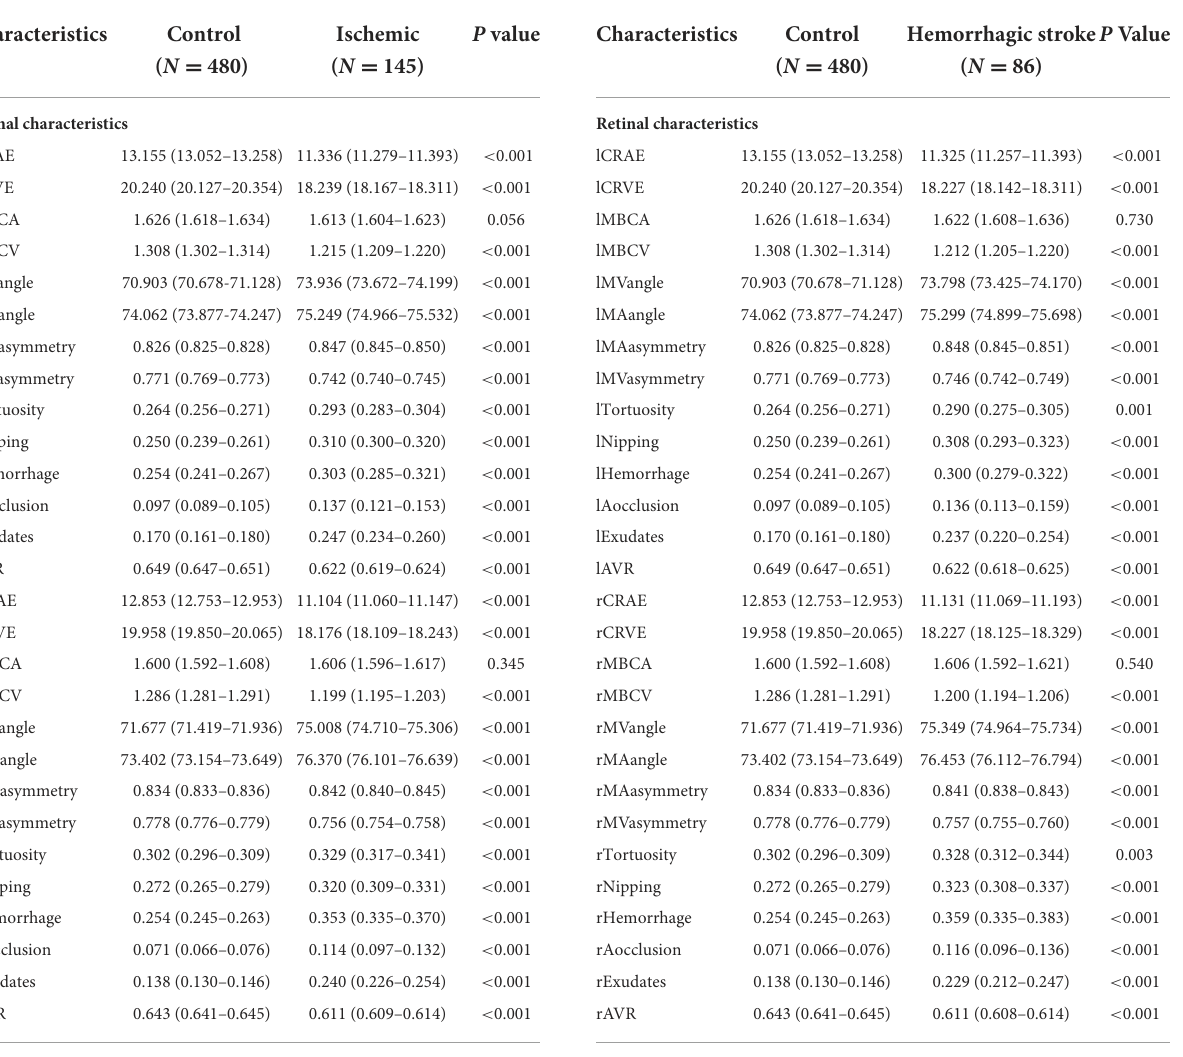
TABLE 2 Comparison of retinal characteristics between control and ischemic stroke.